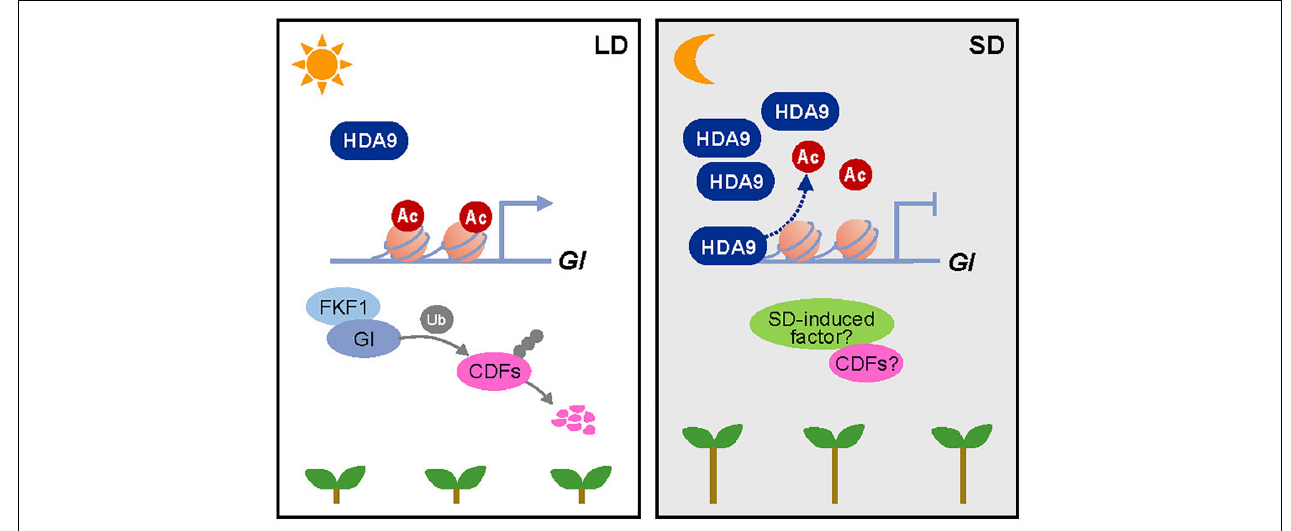
FIGURE 7 | Proposed working model of the HDA9–GI module demonstrating its role in photoperiodic hypocotyl elongation. In short days (SDs), the HDA9 protein accumulates at dusk and then binds to the GIGANTEA ( GI ) promoter. This binding of HDA9 to the GI promoter facilitates the removal of H3ac from the region surrounding the transcription start site (TSS) of GI , thus repressing its expression in SDs. The HDA9–GI module regulates hypocotyl elongation in a photoperiod-dependent manner, possibly by acting together with as-yet-unidentified SD-activated molecular